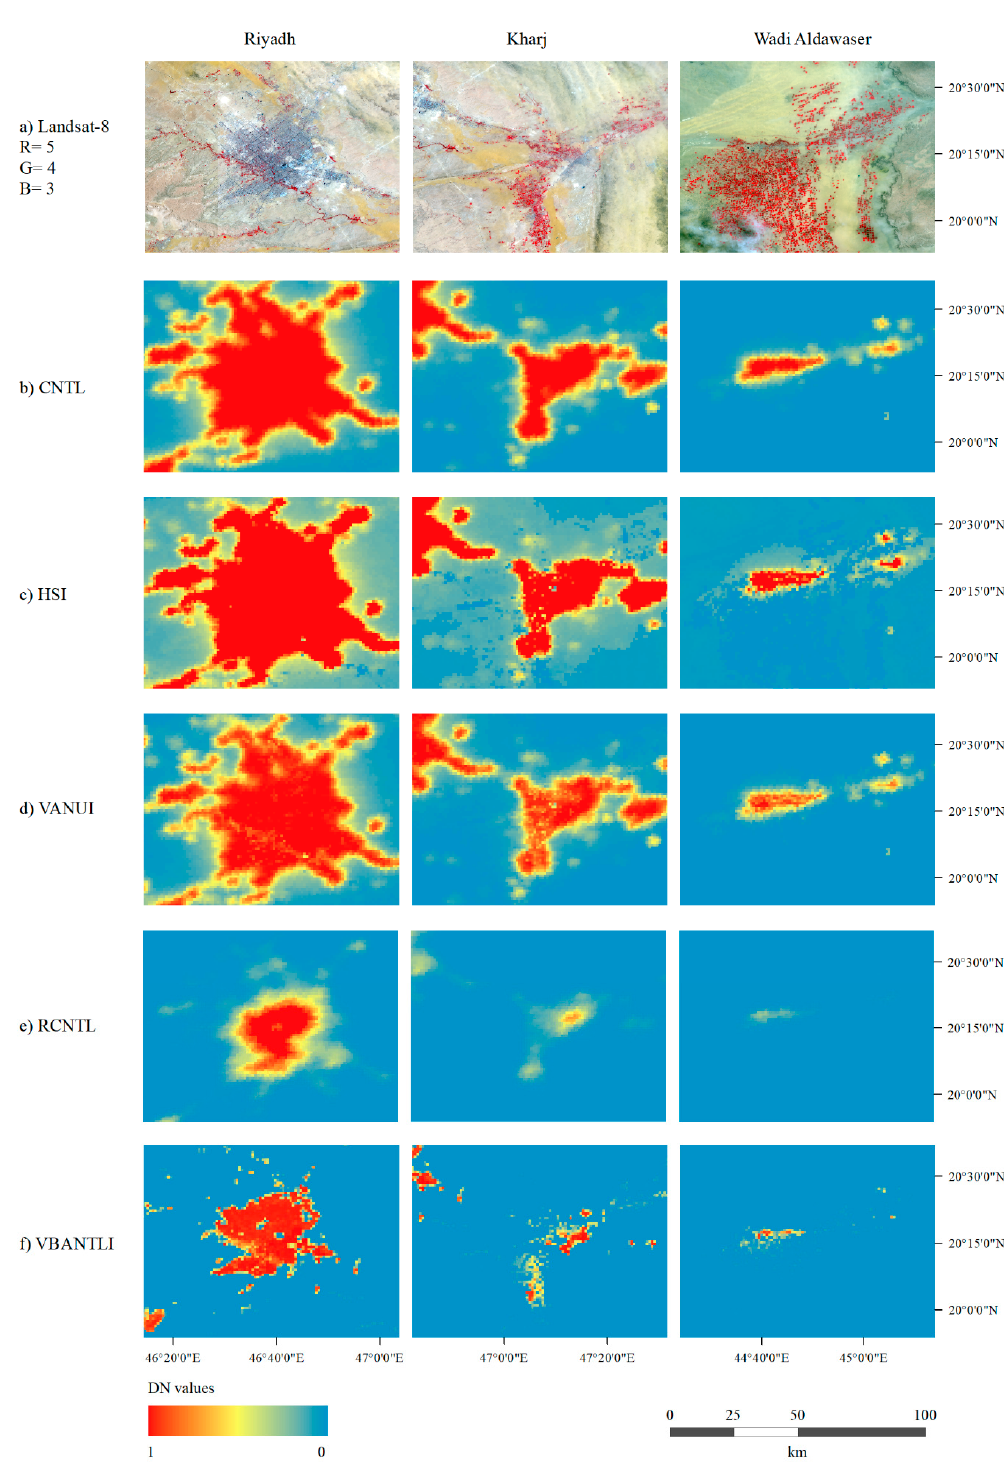
Figure 5. Comparison of ( a ) Landsat-8; ( b ) CNTL; ( c ) HSI; ( d ) VANUI; ( e ) RCNTL; and ( f ) VBANTLI of Riyadh, Kharj, and Wadi Aldawaser cities, respectively.